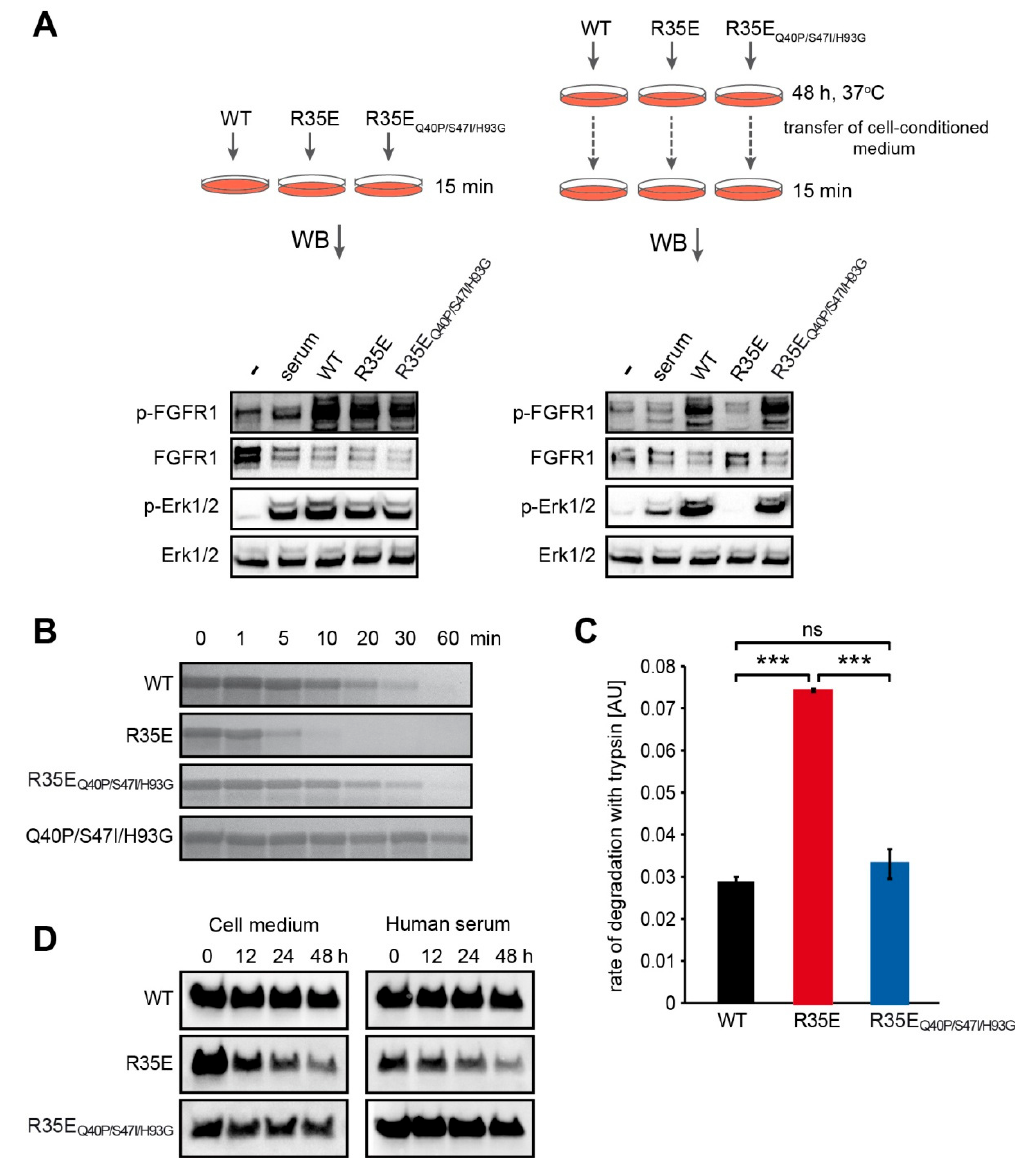
Figure 4. Decreased stability of R35E mutant. ( A ) Stability of FGF1 variants upon incubation with NIH 3T3 cells. Serum-starved NIH 3T3 cells were stimulated for 15 min with either freshly prepared 50 ng / mL of FGF1 variants and 10 U / mL heparin (left panel) or cell-conditioned media after 48-h incubation with 50 ng / mL FGF1 variants in the presence of 10 U / mL heparin (right panel). Activation of FGFR downstream signaling was evaluated by immunoblotting. ( B , C ) Limited proteolysis of FGF1 variants using trypsin. ( B ) FGF1 proteins (200 µ g / mL) were treated with trypsin (15 µ g / mL) and their degradation was monitored by SDS-PAGE. ( C ) Rate of proteolytic degradation of FGF1 variants (200 µ g / mL) by trypsin (15 µ g / mL) determined based on fluorescence emission intensity at 353 nm upon excitation at 280 nm. Slope of the linear regression of tryptophan fluorescence signal as a function of time was used as a measure of FGF1 proteolytic susceptibility. The data shown are mean values of three independent experiments ± SD. Statistical significance: ns—not significant, *** p < 0.001. ( D ) Degradation of FGF1 in NIH 3T3 cell-conditioned medium and in human serum. Serum-starved NIH 3T3 cells or human serum were incubated in the presence of heparin (10 U / mL) with 100 ng / mL or 500 ng / mL of FGF1 variants, respectively. The intact FGF1 proteins were recovered by a ffi nity purification and detected by immunoblotting using anti-FGF1